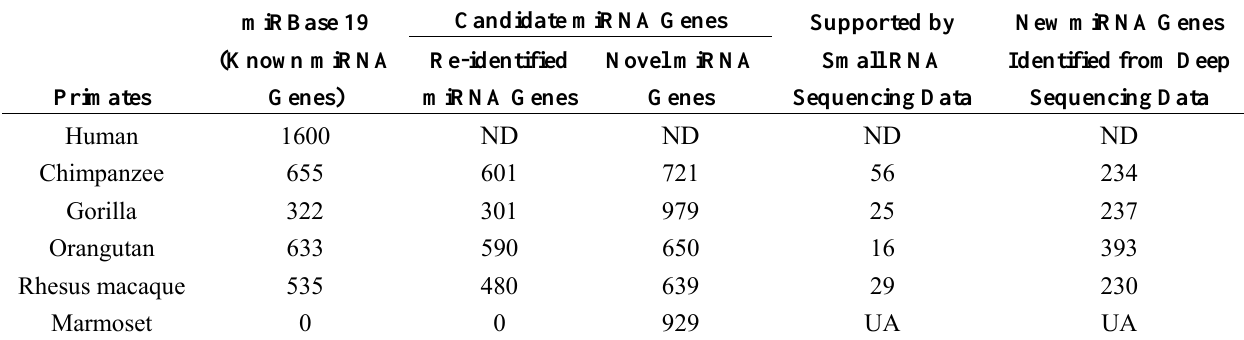
Table 1. The number of pre-miRNAs predicted by our method and new pre-miRNAs identified from small RNA sequencing data. The potential pre-miRNAs were identified by MiPred program. ND: No data; UA: The small RNA sequencing data is